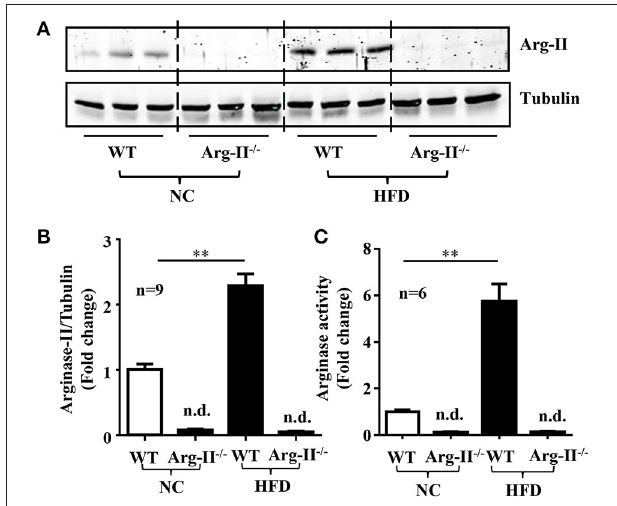
FIGURE 1 | Enhanced renal Arg-II expression and activity in HFD-induced obesity. (A) Immunoblotting analysis of Arg-II expression in WT and Arg-II − / − mice with NC and HFD. (B) Bar graphs show quantification of Arg-II protein expression and (C) activity. n = 9 for protein levels and n = 6 for enzymatic activity, ** p < 0.01 between indicated groups, n.d., not